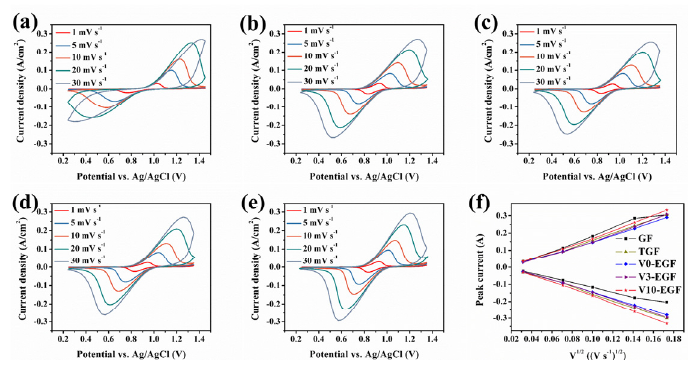
Figure 6. ( a – e ) GF, TGF, V0-EGF, V3-EGF, and V10-EGF at various scan rates in positive electrolyte. ( f ) plots of the redox peak current density versus the square root of GFs.